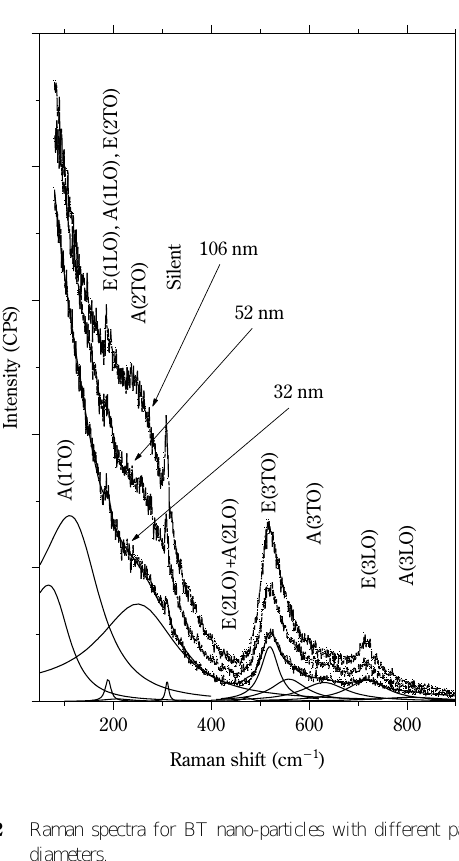
Fig. 2 Raman spectra for BT nano-particles with different particle diameters.